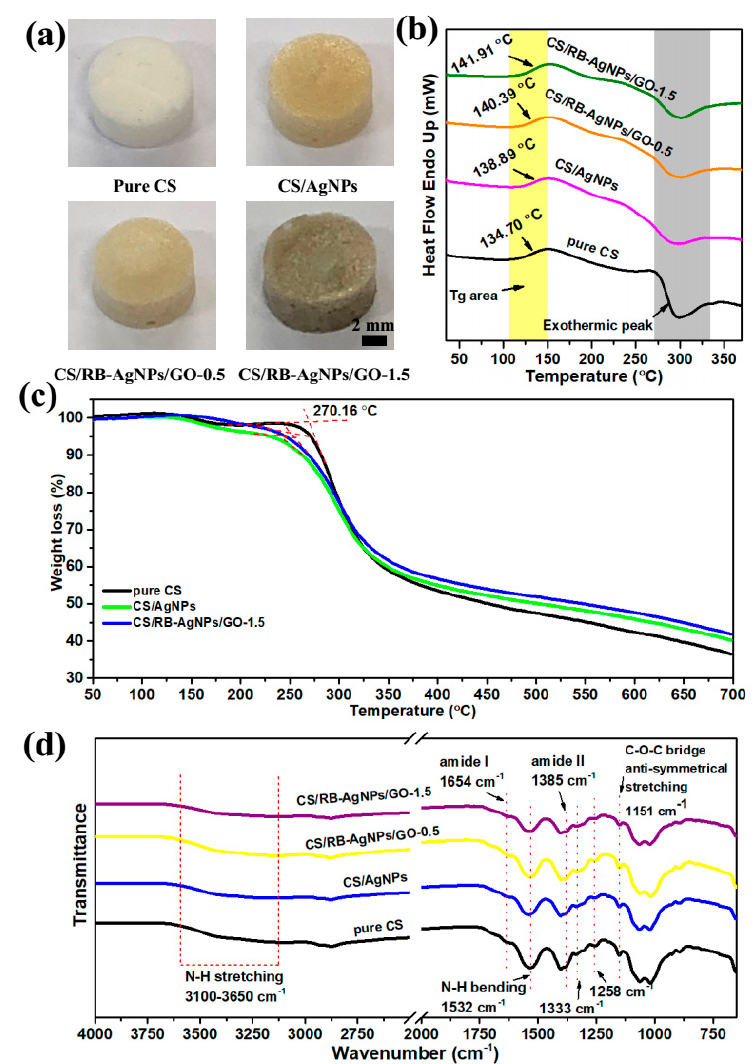
Figure 2. ( a ) Optical images of pure CS and the typical nanocomposite samples, ( b ) DSC curves, ( c ) TGA curves obtained from the second heating, and ( d ) FT-IR spectra of pure CS, CS/AgNPs, CS/RB-AgNPs/GO and CS/RB-AgNPs/GO nanocomposites.